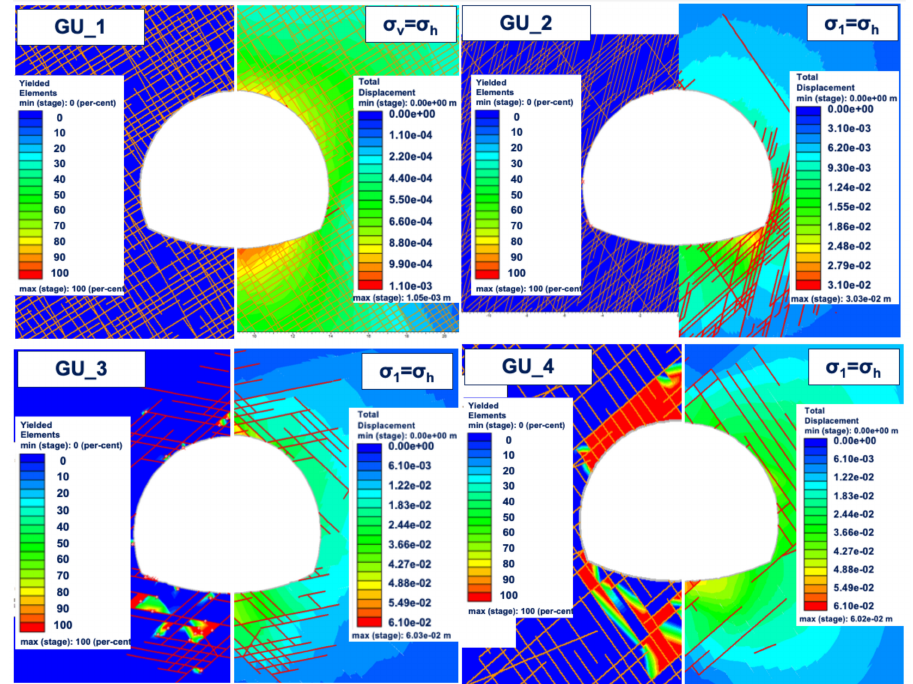
Figure 14. Numerical results of the four Geotechnical Units (GU_1–4) expressed in total displacements and yielded elements.